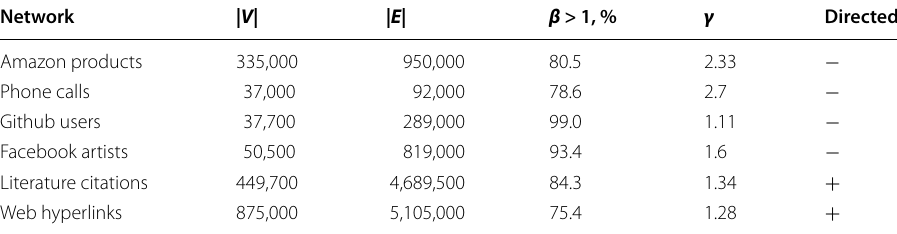
Table 1 Networks and their characteristics of friendship index distribution, β is the friendship index, γ is the power law exponent Network |V| |E| β > 1, %